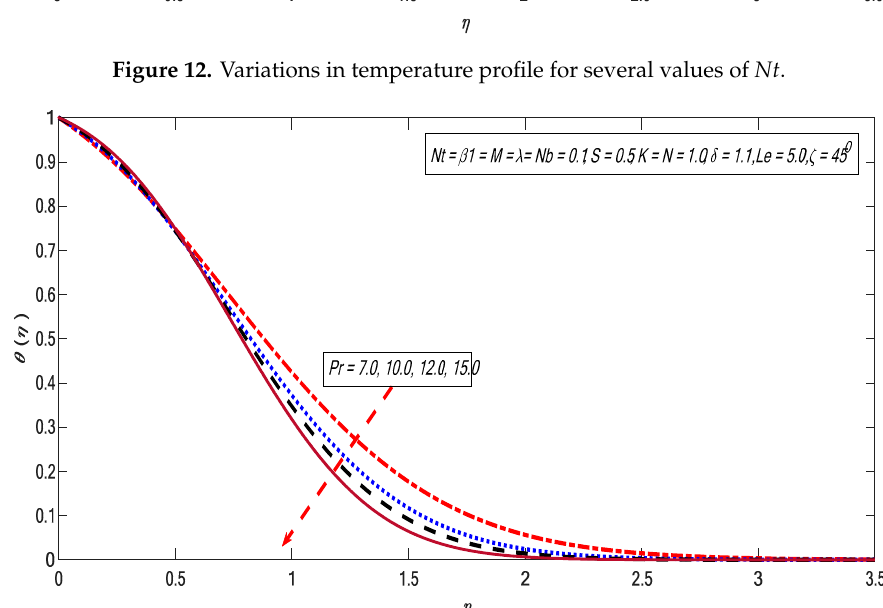
Figure 12. Variations in temperature profile for several values of 𝑁𝑡 .